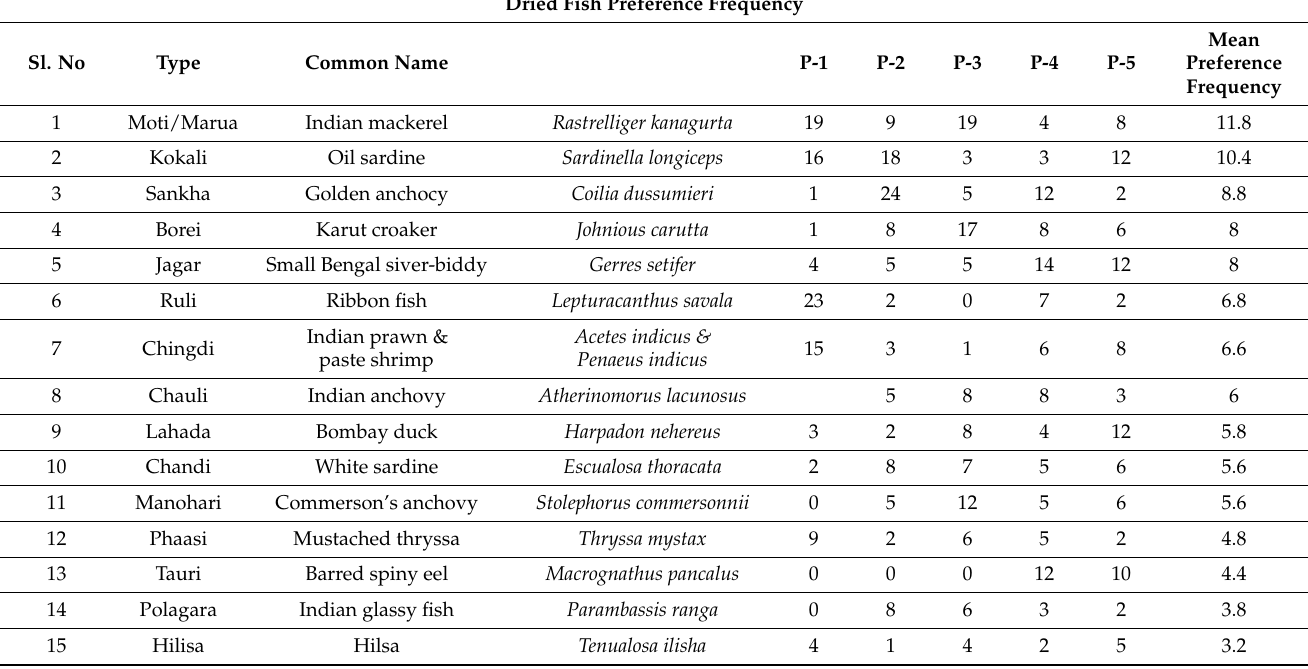
Table 3. Dried fish species preference